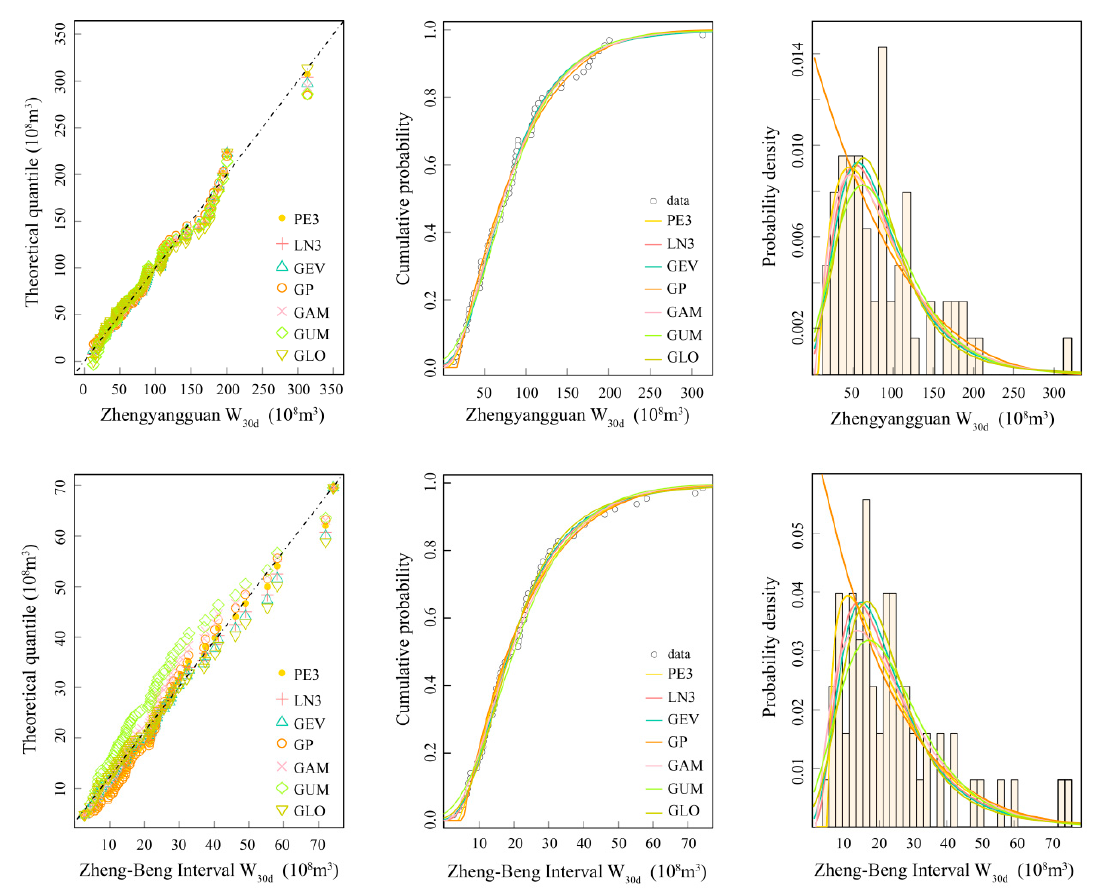
Figure 4. Fitting distributions to Zhengyangguan W 30d and Zheng-Beng interval W 30d : The quantile-quantile plot ( left ), C.D.F plot ( middle ), and P.D.F plot ( right ).